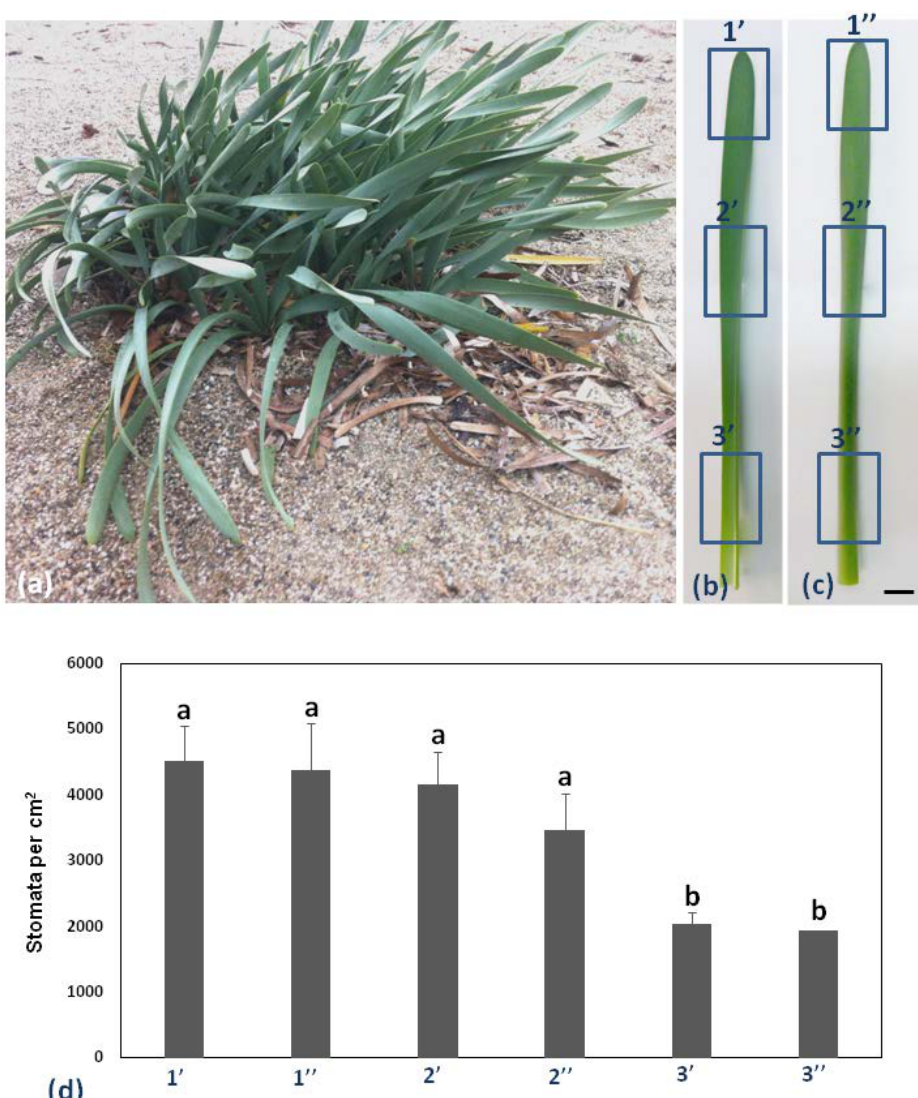
Figure 1. Pancratium maritimum morphology and stomata density. ( a ) P. maritimum plants growing in a sand dune. b, c: The six parts of the leaf blade [ 1′ , 2′ , 3′ abaxial (lower), 1 ′ , 2 ′ , 3 ′ adaxial (upper)]. ( b ) The adaxial surface and ( c ) the abaxial surface of the same leaf. ( d ) Diagram of stomata distribution in six parts of the leaf of P. maritimum . Measurements are the mean of 10 leaves of the same size. Statistical significance ( p < 0.05) is marked by the different letters. Scale bars in b, c: 1 cm. Stomatal density appeared to decrease in a basipetal direction, while it was lower on the abaxial than the adaxial epidermis (Figure 1d). P. maritimum leaf epidermis is covered by a thick cuticle (arrow in Figure 2b) and is amphistomatic (arrowheads in Figure 2b). Individual vascular bundles (asterisks in Figure 2a) were observed in the middle of the mesophyll. Guard cells were kidney-shaped (arrows in Figure 2c). No special subsidiary cells were found flanking guard cells (anomocytic stomata) (arrows in Figure 2c). Guard cells display thickenings in their ventral cell wall (white squares in Figure 2d), while ledges are formed on both sides (arrowheads in Figure 2d). Pavement cells display a particularly thickened external periclinal cell wall (white asterisks in Figure 2b,d), while they appear rectangular on cross-section (Figure 2a,b) and their long axis is parallel to that of the leaf (Figure